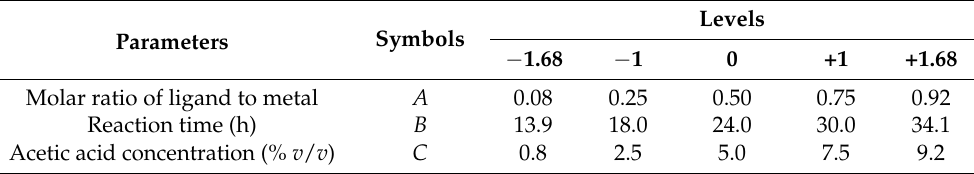
Table 7. Levels of three independent